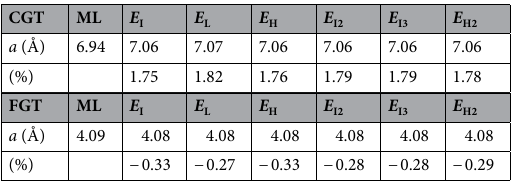
stacked structures illustrated in the bottom panel were examined; the purple triangle consisting of interface Te CGT atoms was rotated 180° relative to those in the top panel. Two more intermediate energy structures, E I2 and E I3 , and another highest energy structure, E H2 , were found. In E I2 , E I3 , and E H2 structures, the interface Te CGT atom is above the Fe1 FGT , Ge FGT , and Te FGT atoms, respectively. Figure 2c presents the total energy difference with the FM (red) and AFM (blue) spin alignments, as well as the interlayer distance (brown) between the interface Te atoms of the FM structures. All the atoms and axes were optimized during the relaxation in the x- , y- , and z -directions using the spin-polarized optB88 vdW method. The total energy difference changes gradually from E I through E L to E H (left panel) and from E I2 through E I3 to E H2 (right panel). The total energy difference and the interlayer distance are the smallest for E L and the largest for E H and E H2 . E I , E L , E H , E I2 , E I3 , and E H2 structures have interlayer distances of 3.39 Å, 3.22 Å, 3.78 Å, 3.33 Å, 3.31 Å, and 3.71 Å, respectively. At each FM heterobilayer, the lattice constants of the CGT and FGT layers become tensile strained and compressive strained, respectively, as summarized in Table 1. The total energy of FM spin alignment is lower than that of AFM for E I , E L , E H , E I2 , E I3 , and E H2 by 0.02 eV, 0.04 eV, 0.02 eV, 0.02 eV, 0.05 eV, and 0.03 eV, respectively. At the FM spin alignment, the total energy of the E L structure is lower than that of E I , E H , E I2 , E I3 , and E H2 structures by 0.08 eV, 0.30 eV, 0.06 eV, 0.03 eV, and 0.29 eV, respectively. Figure 2d shows the binding energy, E b , per Cr atom along the z- direction regarding the small displacement. At the equilibrium position, the binding energy per Cr atom obtained using the spin-polarized optB88 vdW method has a negative value of − 0.44 eV, − 0.58 eV, and − 0.54 eV for E H , E L , and E I , respectively. The lower the total energy is, the lower the binding energy is. In the PBE + U + SOC method, the FM spin alignment also has lower energy than the AFM spin alignment when U is 3–4 eV and J = 1 eV for all the stacked structures, as shown in Fig. 2e. The band alignment of FM and AFM heterobilayers was investigated. Figure 3 shows the magnetic moment (left panels), spin-majority (up) and spin-minority (down) band structures (middle panels), and atom projected density of states (PDOS, right panels) of (a) the FM CGT-only system, (b) FM FGT-only system, (c) FM FGT/ CGT heterobilayer for E H , and (d) AFM FGT/CGT heterobilayer for E H in the supercell band lines. The band structures were calculated by using the noncollinear PBE + U + SOC method on Cr 3 d orbitals with U = 3.5 eV and J = 1.0 eV. It should be noted that the CGT (FGT)-only system refers to only the CGT (FGT) layer and no FGT (CGT) layer while maintaining the relaxed heterobilayer structures. The band projections onto the spin- up and spin-down bands of Cr or Fe atoms are distinguished by red and blue colors, respectively, with various color intensities proportional to the projection magnitude to examine the band alignment. The semiconducting bandgap of 0.43 eV is shown for a Cr atom in the FM CGT-only system (Fig. 3a), while the metallic band struc- ture is shown for a Fe2 atom in the FM FGT-only system (Fig. 3b). The magnetic moment is 3.69 µ B /atom for Cr, 2.62 µ B /atom for Fe1, and 1.67 µ B /atom for Fe2. The atom PDOS of a Fe2 atom in (b) indicates an equivalent magnitude of spin-up and spin-down PDOS near the Fermi level. The CGT-only system features a conduction band minimum (CBM) at a k point between the Ŵ and K points dominated by spin-up empty Cr 3 d e g bands. Its valence band maximum (VBM) at the Ŵ point is dominated by Te 5 p orbital characteristics, similar to the pristine ML CGT. On the other hand, the heterobilayer formed by CGT- and FGT-only systems is an FM metal, as shown in Fig. 3c. The bands projected on a Cr atom show the initial Cr bands observed in the CGT-only system as well as unique spin-up hybridized bands with Fe2 bands crossing the Fermi level, as indicated by green and blue arrows, respectively. The hybridization is not related to Fe1 bands, as seen by the band projected on a Fe1 atom. Fur- thermore, when the hybridized spin-up bands are ignored, the CBM of Cr bands appears to be at the spin-down bands, located at an energy close to the Fermi level, generating an n -type CGT layer. The n -type CGT means that electrons are transferred from the FGT to CGT layers. In the right panel of Fig. 3c, the downward-band shifts of a Cr atom in the heterobilayer can be observed in the atom PDOS. The spin-up Fe2 bands shift higher in energy near the Ŵ point when the system switches from an FGT-only system to a heterobilayer, as indicated by the black arrows in (b) and (c). These upward shifted spin-up Fe2 bands might also originate from the electron transfer from the FGT to CGT layers. Unlike the FM heterobilayer, the AFM-heterobilayer-band structures do not exhibit hybridized bands between FGT and CGT bands but do expose an n -type CGT layer via the spin-up and spin-down CBM of the original Cr bands crossing the Fermi level. AFM heterobilayer, like FM heterobilayer, features shifted spin-down Fe2 bands near the Ŵ point that are higher in energy than those of the FGT-only system (black arrow in (d)), indicating electron transfer from the FGT to CGT layers. Figure 4 shows the spin-up (red) and spin-down (blue) band structures projected on a Cr atom of all the stacked structures with the FM spin alignment. All the band structures exhibit spin-up hybridized bands crossing